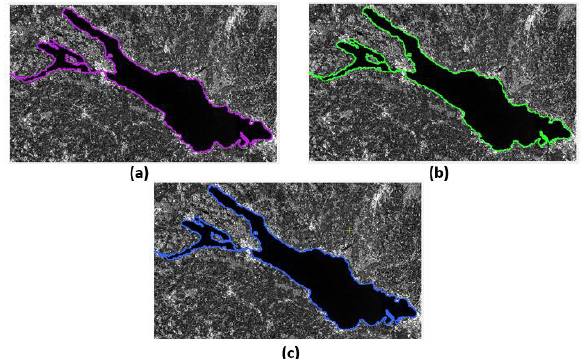
Figure 10. Shoreline extraction results. (a) Using Mean-Shift segmentation results, (b) Using Random Forest segmentation results, (c) Using Whale Optimization segmentation results The derived results from each method were compared with manually digitized shorelines. The perpendicular distances between reference data and shoreline extraction results have been calculated using 10 m space length which is the spatial resolution of SENTINEL-1A SAR image. Statistics of the perpendicular distances to the reference shoreline were computed. The calculated values are listed in Table 6.